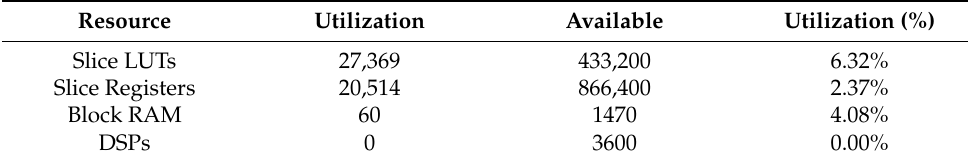
Table 4. Hardware resource utilization of the data controller proposed.